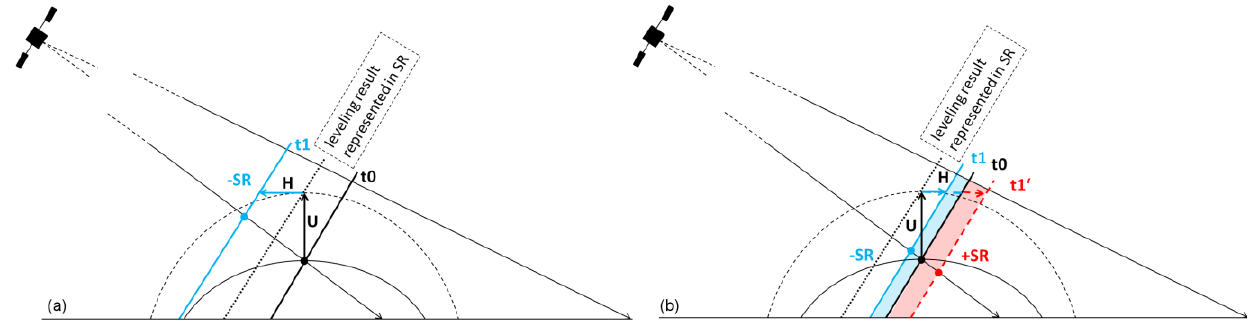
Figure 11. Schematic sketch of the horizontal contribution to the overall LOS displacement. ( a ) When points move toward the satellite during the time interval from t0 to t1, uplift (U), and horizontal (H) components contribute in the same manner to the LOS motion (slant range decreases (-SR)). ( b ) When points move away from the satellite, the horizontal and uplift components have opposing impacts on the LOS motion. Depending on the magnitude of the horizontal motion, this effect can result in an increase of slant range (+SR) with respect to the state at